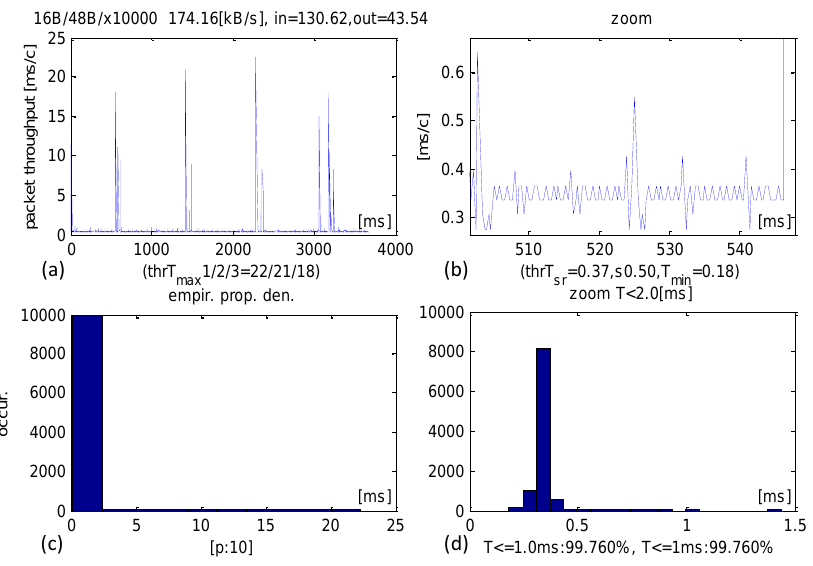
Figure 4. Experimental results of CCLT for packets IN = 48 B. ( a ) Recorded CCLTs. ( b ) Enlargement of selected section. ( c ) CCLT histogram. ( d ) Selective histogram enlargement.